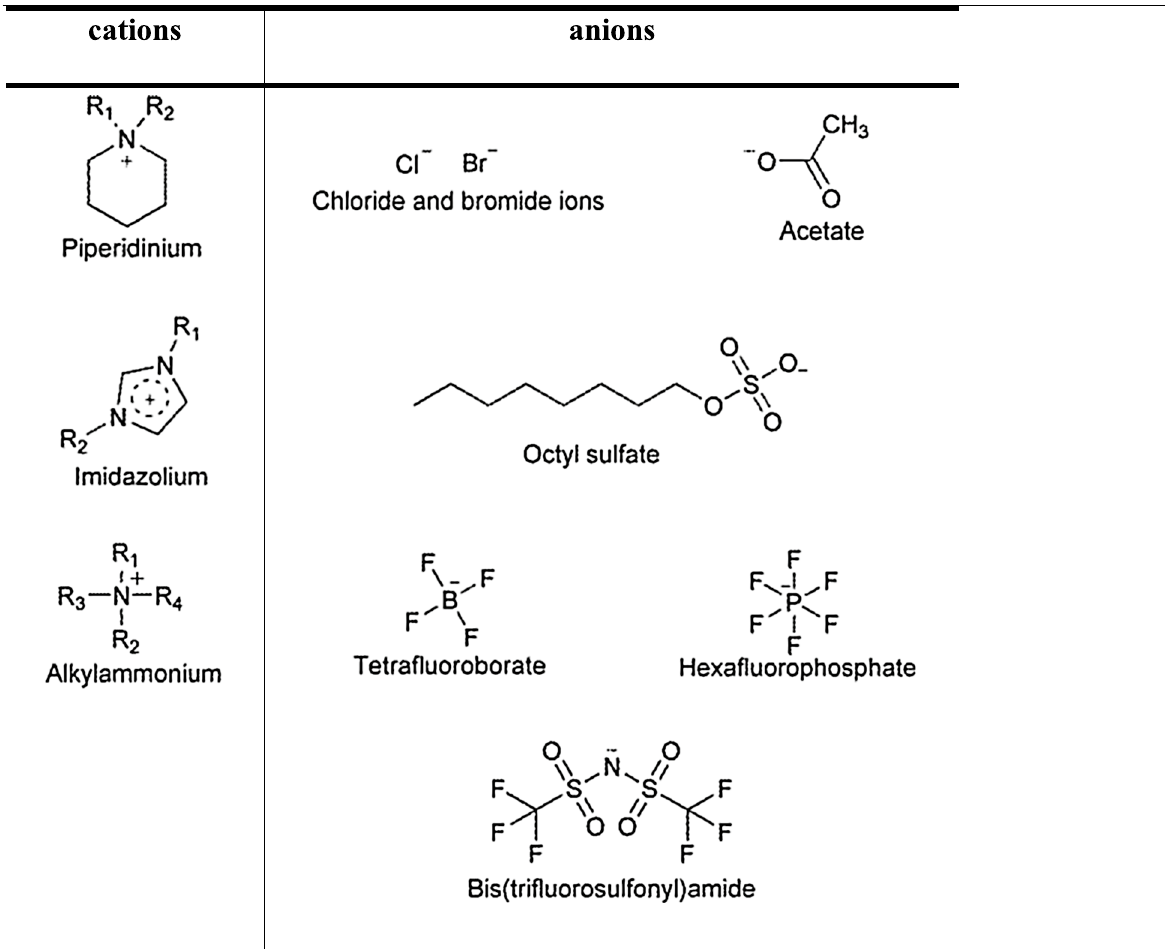
Table 1 Examples for ionic